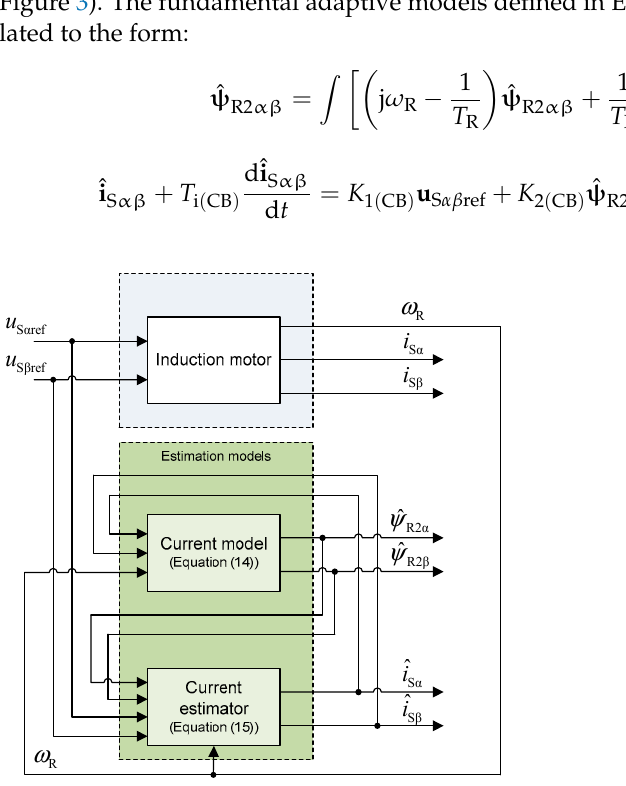
Figure 3. Stator current observer used for stator current sensor fault-tolerant control.